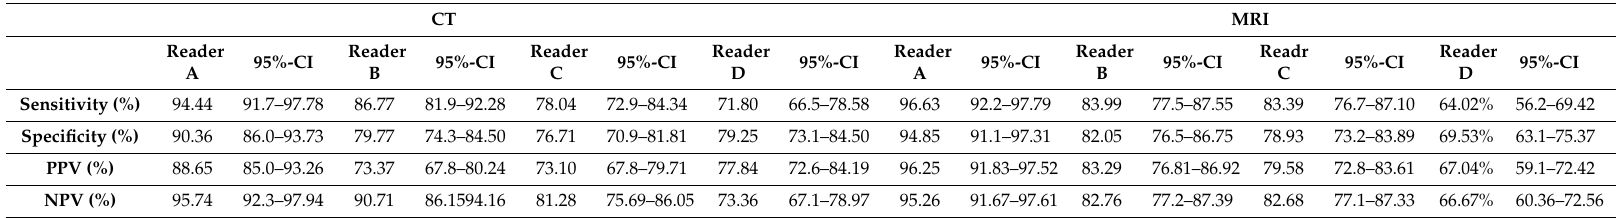
Table 2. CT and MRI sensitivity, specificity, positive predictive value (PPV) and negative predictive value (NPV) on a segmental base achieved by reviewers A ( > 20 y of experience), B ( > 10 y), C ( > 1 y), and D ( < 1 y). Diagnostic performance was mainly proportional to radiological